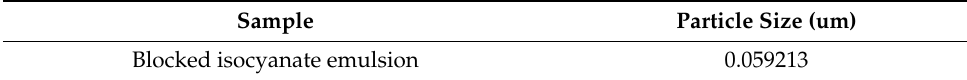
Table 2. Particle size of the blocked isocyanate emulsion.